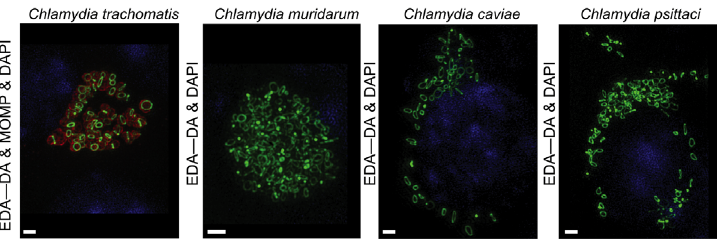
Fig 2. Structured illumination microscopy of DAAD PG labeling in pathogenic Chlamydia . Structured illumination microscopy (SIM) was conducted on four pathogenic Chlamydia species. EDA-DA was added 2 hours post infection (hpi) and coverslips were fixed at 18 hpi. PG labeling (represented by EDA — DA) is shown in green, the major C . trachomatis outer membrane protein (MOMP) is shown in red, and cell nuclei are in blue (this labeling scheme is maintained in all subsequent figures, unless otherwise stated). MOMP staining is not shown for the three other species. Images are representative of ~20 inclusions viewed per strain. Scale bar = 1 μ